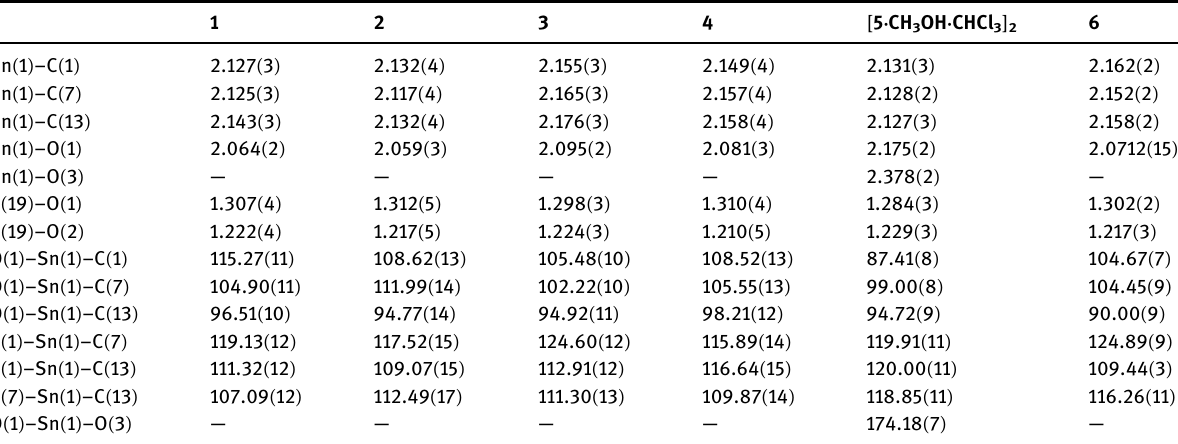
Table 1: Selected bond lengths ( Å ) and angles ( ° ) for the complexes